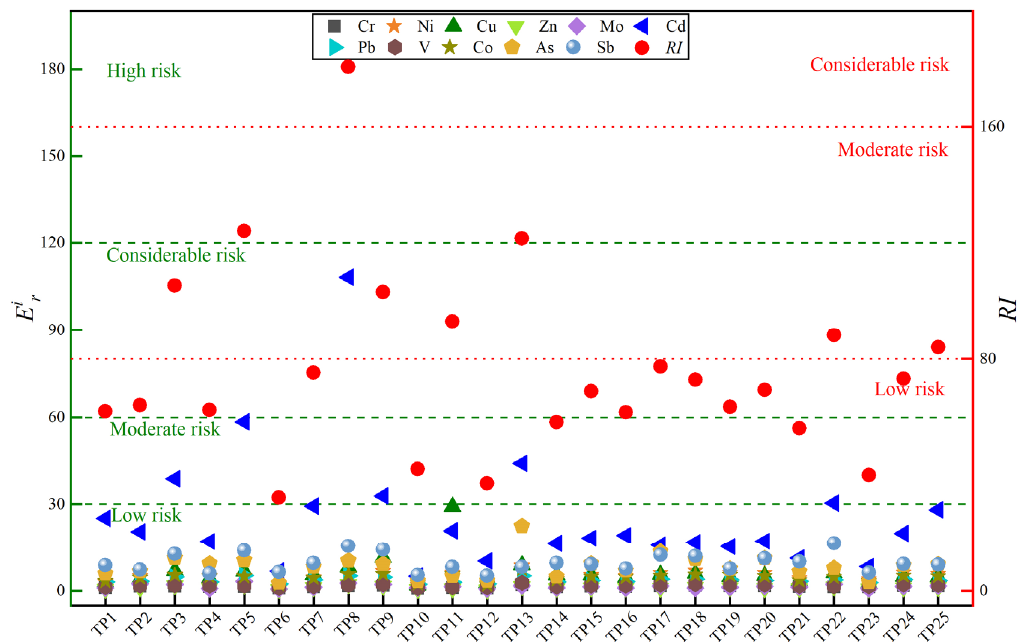
Figure 4. Potential ecological risk index ( E (cid:3045)(cid:3036) 𝑎𝑛𝑑 𝑅𝐼 ) of PTEs in surface sediments of Taipu River.